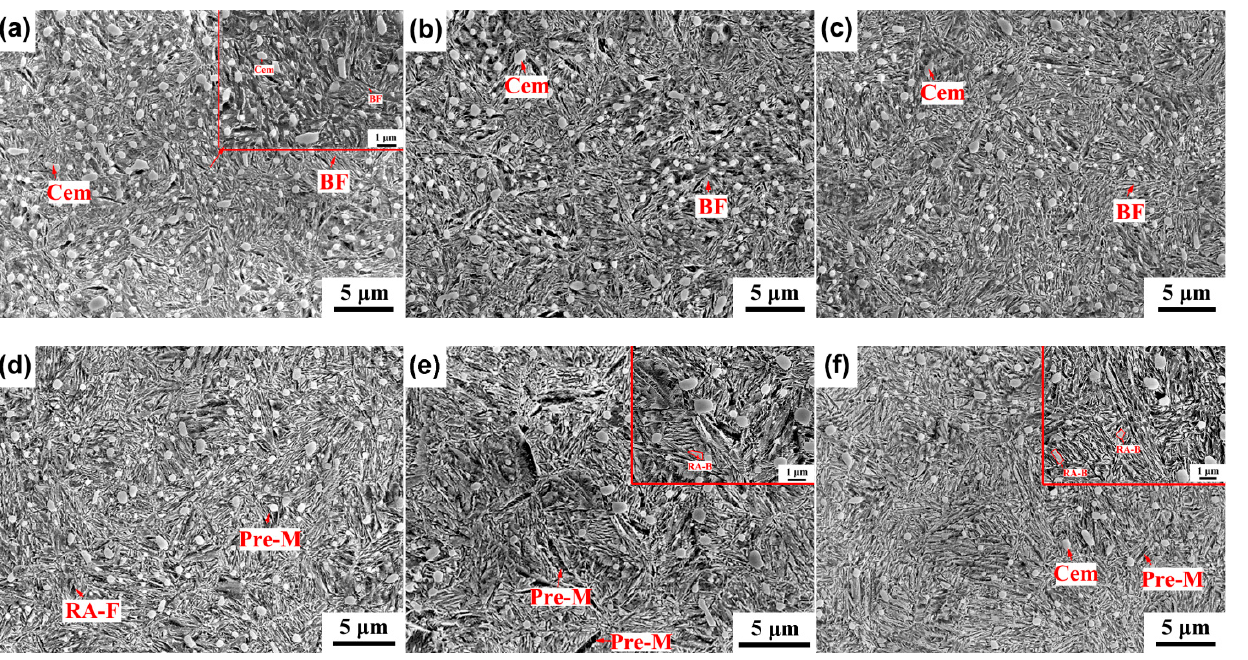
Figure 2. SEM images of specimens with different treatment processes: ( a ) 0 M, ( b ) 5 M, ( c ) 10 M, ( d ) 15 M, ( e ) 20 M, ( f ) 25 M. BF: bainitic ferrite, Cem: cementite, Pre-M: preformed martensite, RA-F: filmy retained austenite, RA-B: blocky retained austenite.